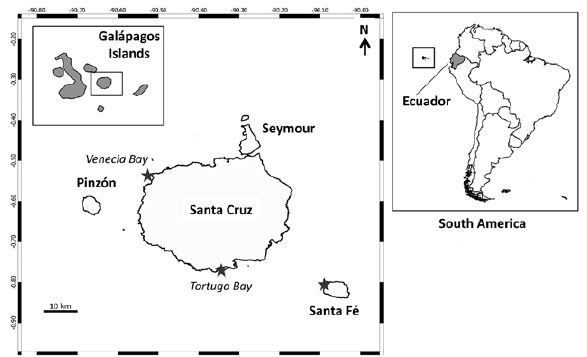
Fig. 1. – Sampling sites: Santa Fé Island (0°48 ′ 16.36 ″ S; 90°5 ′ 7.522 ″ W), Tortuga Bay (0°45 ′ 58.43 ″ S; 90°20 ′ 42.373 ″ W)